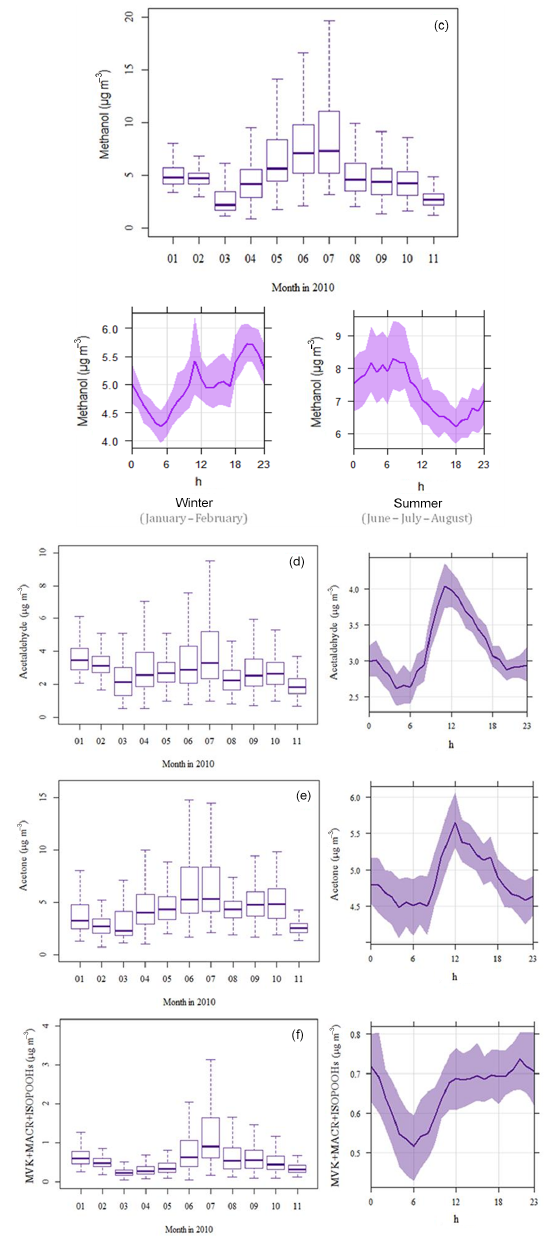
Figure 7. Left: monthly box and whisker plots of benzene (a) , toluene (b) , methanol (c) , acetaldehyde (d) , acetone (e) and MVK + MACR + ISOPOOHs (f) expressed asµgm − 3 . Solid lines represent the median concentration and the box shows the IQR. The bottom and top of the box depict the 25th (the first quartile) and the 75th (the third quartile) percentile. The ends of the whiskers corre- spond to the lowest and highest data still within 1.5 times the IQR of Q1 and Q3, respectively. Right: diurnal variations of (O)VOCs averaged over the whole sampling period. Time is given as local time. Lines correspond to hourly means and shaded areas indicate the 95% confidence intervals of the